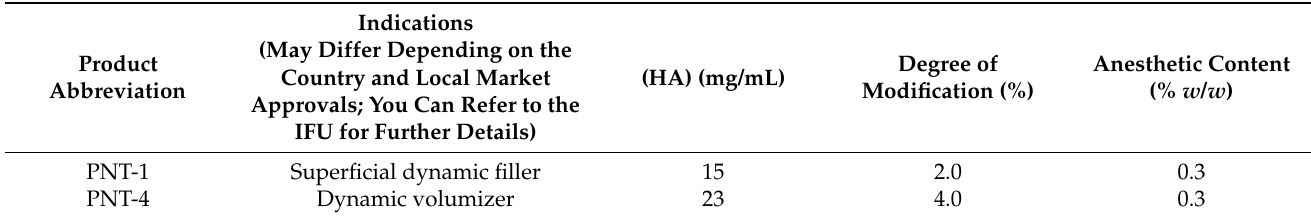
Table 1. Intended use and composition of the investigated